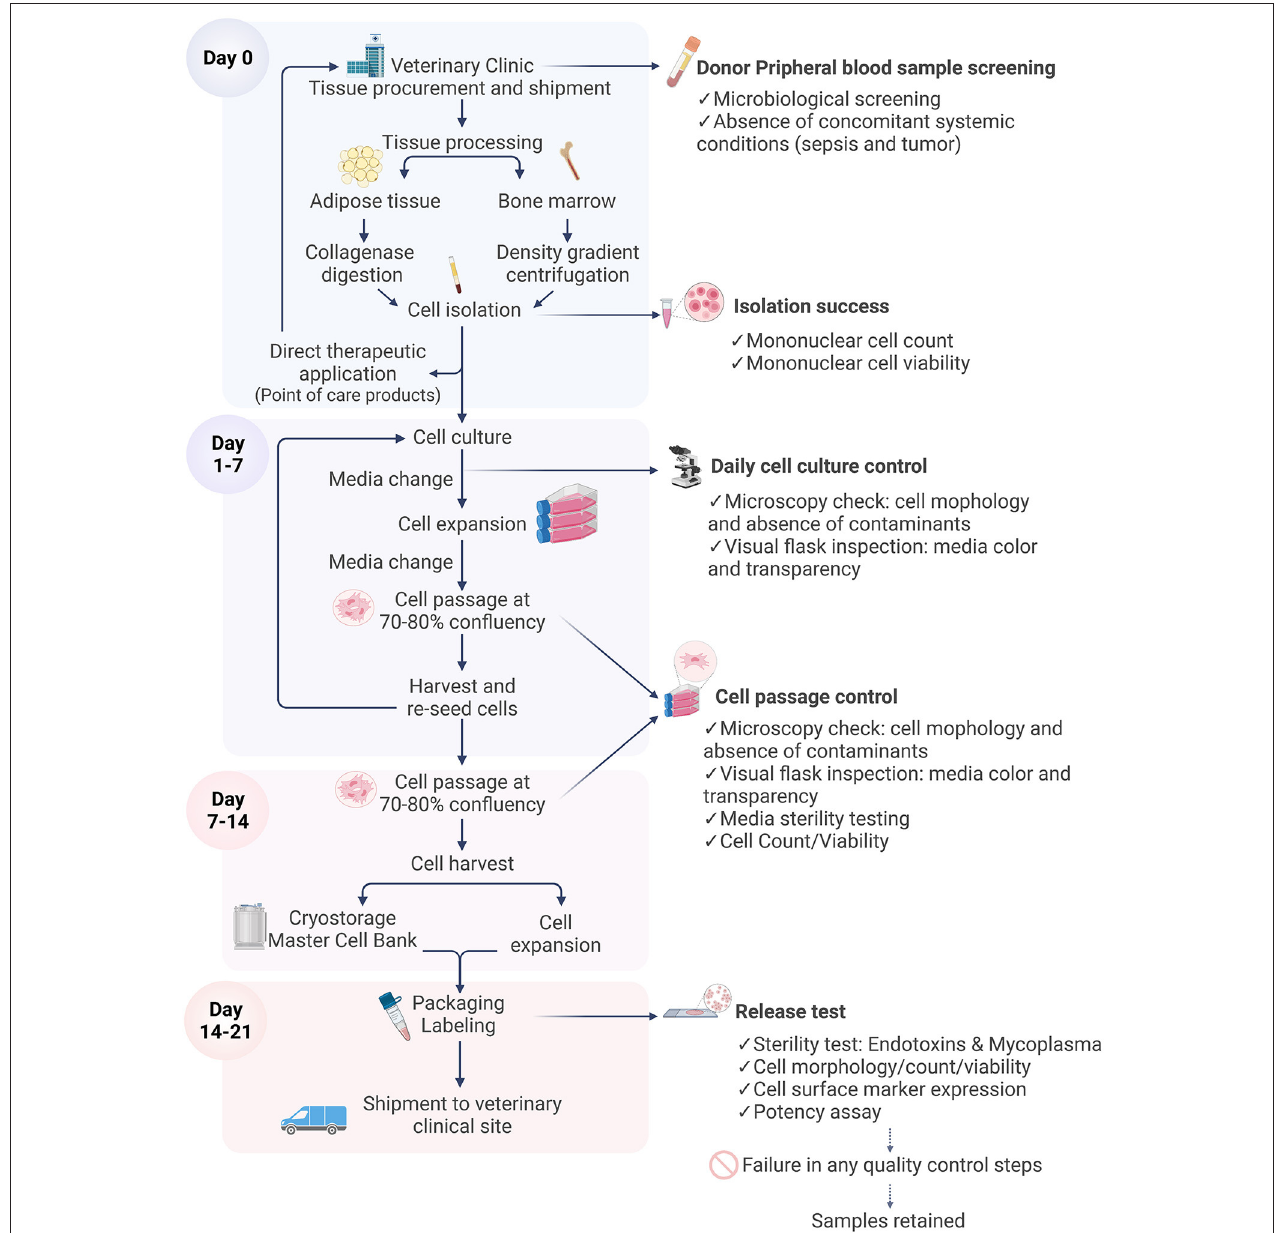
FIGURE 4 | Flow diagram illustrating cell manufacturing stages. The cell manufacturing process starts with tissue sampling at the veterinary clinic. Each stage is critical and is subject to quality control and sterility testing prior to shipment of the final characterized cell product for therapeutic application. In the case of failure of any quality control step, the batch is discarded and in the final stages the sample is retained. Figure created with